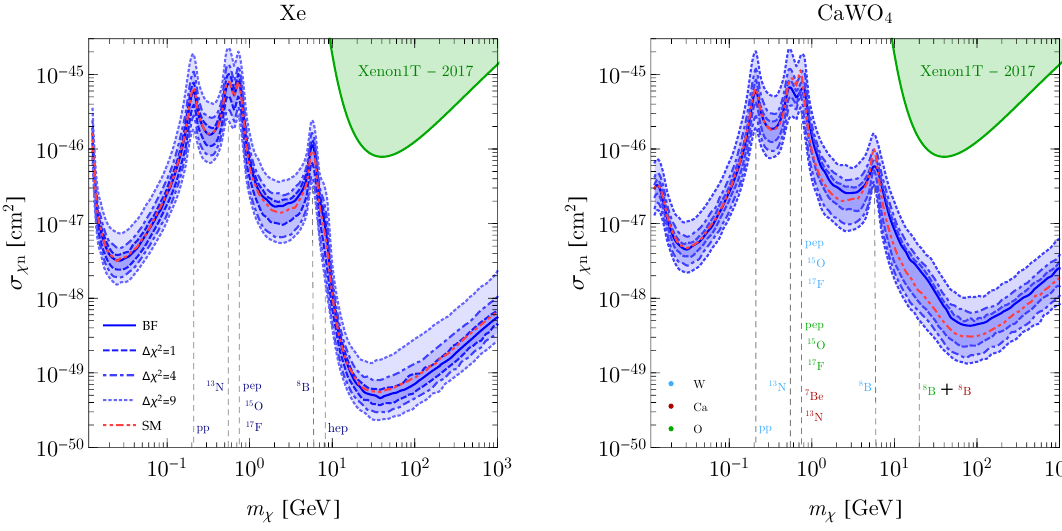
Figure 3 . Impact on the discovery limit induced by NC-NSI couplings with up quarks for an ideal- ized detector with a Xe target (left) and a calcium tungstate (CaWO 4 ) target (right), a threshold of E th = 0 : 01 eV, a 10 3 ton-year exposure, and 100% e(cid:14)ciency ( " ( E R ) = 1). For illustration, we mark with vertical dashed lines the solar neutrino (cid:13)ux components dominating the background for some values of m (cid:31) at each target; for the CaWO 4 , the color indicates the contribution of the di(cid:11)erent elements. The red dashed lines corresponds to SM predictions while the blue full lines to the best (cid:12)t values of the parameters of the global analysis of oscillation+COHERENT data. The shaded regions bordered by dashed, dot-dashed, and dotted lines correspond to predictions with NC-NSI and oscillation parameters within (cid:1) (cid:31) 2 (cid:20) 1, 4, 9, respectively. The green shaded region is OSC+COH excluded by the Xenon1T experiment at 90% CL